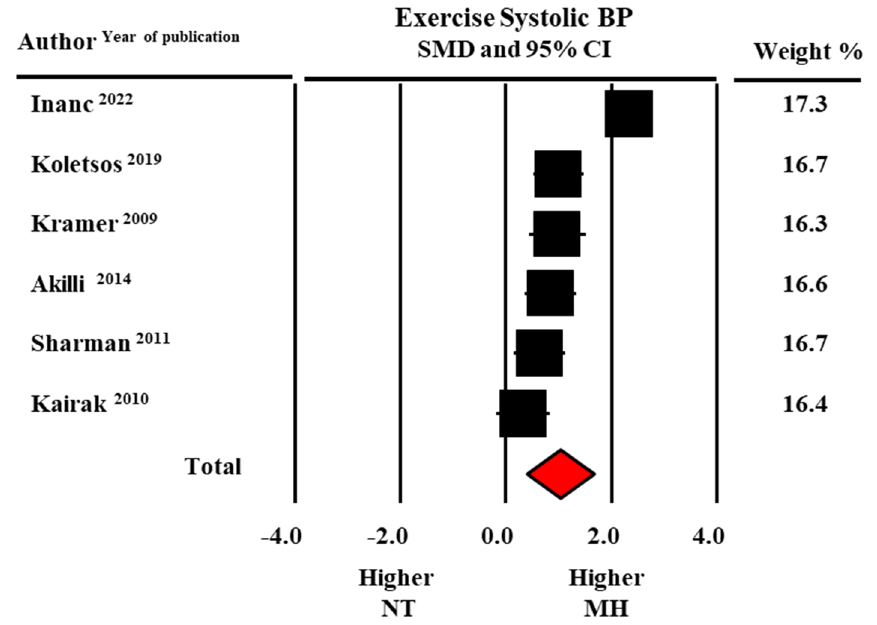
Figure 4. Forest plot of systolic blood pressure (BP) at peak exercise in masked hypertensive (MH) and normotensive (NT) individuals. Standard mean difference (SMD) and 95% confidence interval (CI). Fixed model [21–24,28,29].